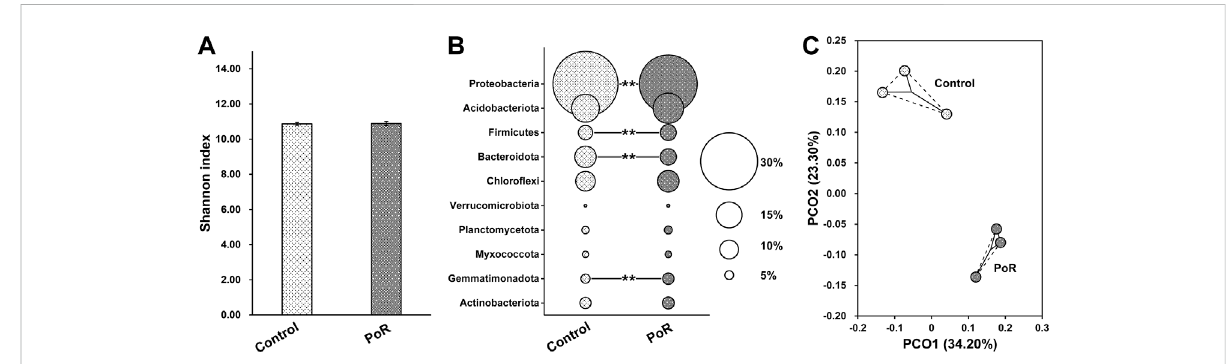
FIGURE 1 Shannondiversity (A) andtaxonomiccomposition (B) ofthebacterialcommunityunderdifferenttreatments;PCoAplot (C) showingvariationinthe bacterial community under different treatments. ** indicates a signi fi cant difference between PoR and control (Kruskal – Wallis rank sum test, p < 0.01).